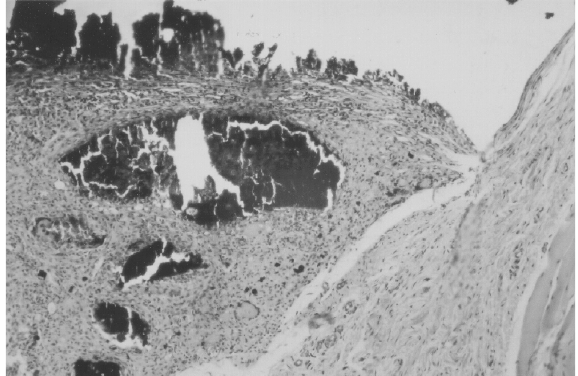
FIGURA 7- Apexit – 21 dias: tecido de granulação capsular. Intensa atividade macrofágica sobre o material extravasado. HE Nikon 100x